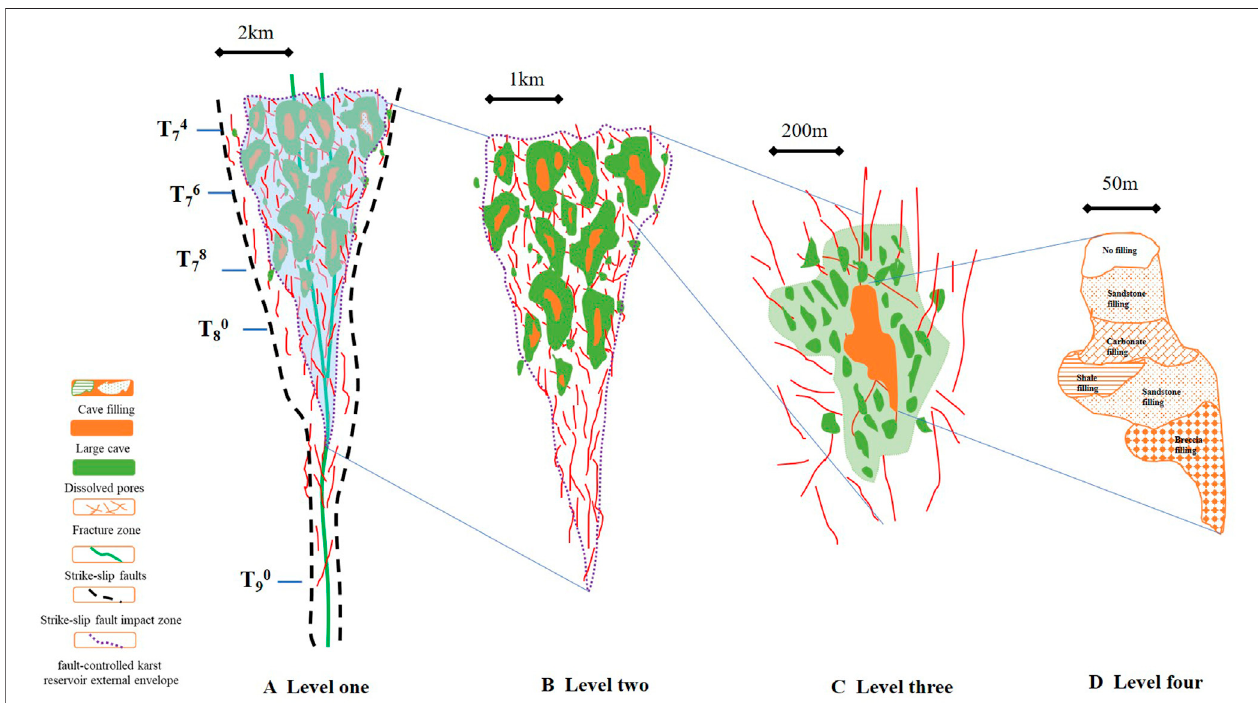
FIGURE3| Fault-controlledpaleokarsthierarchyscheme. (A) strike-slipfaultimpactzone; (B) fault-controlledexternalkarstreservoirenvelope; (C) fault-controlled internalkarstelements; (D) caveinternal fi llingzone. Remarks:T 74 :TopoftheYijianfang Formation, T 76 :Topofthelowermember oftheYingshanFormation, T 78 :Topof the Penglaiba Formation, T 80 : Top of the Cambrian, T 90 : Bottom of the Lower